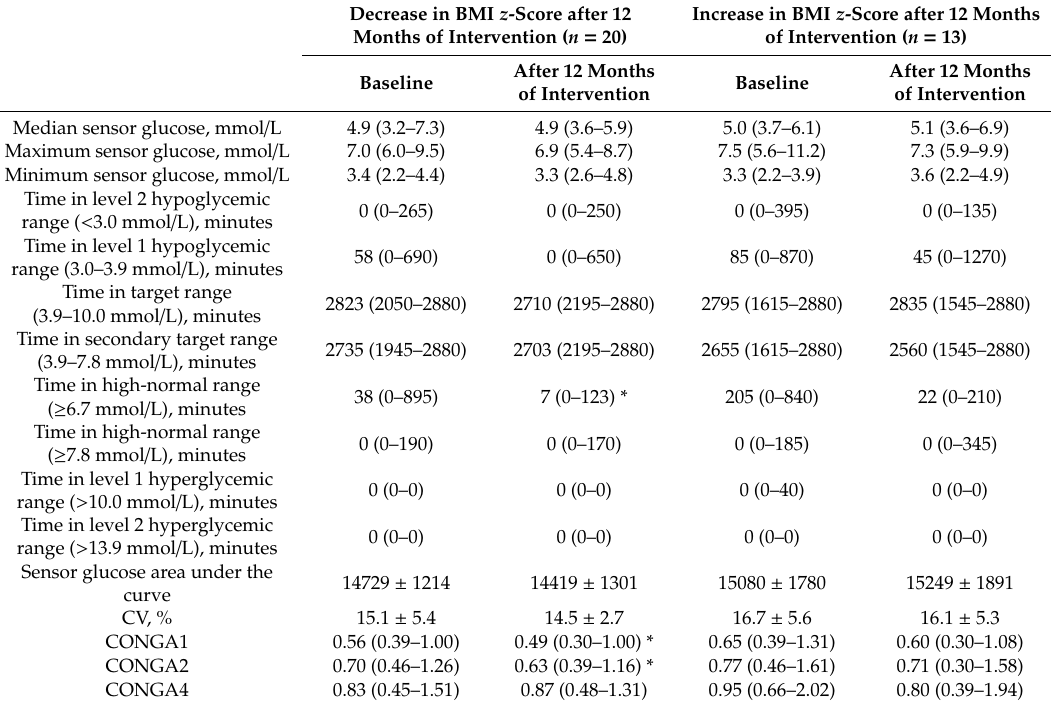
Table 3. The 48-hour sensor glucose measurements stratified for changes in BMI z -score. Decrease in BMI z -Score after 12 Increase in BMI z -Score after 12 Months Months of Intervention ( n = 20) of Intervention ( n =